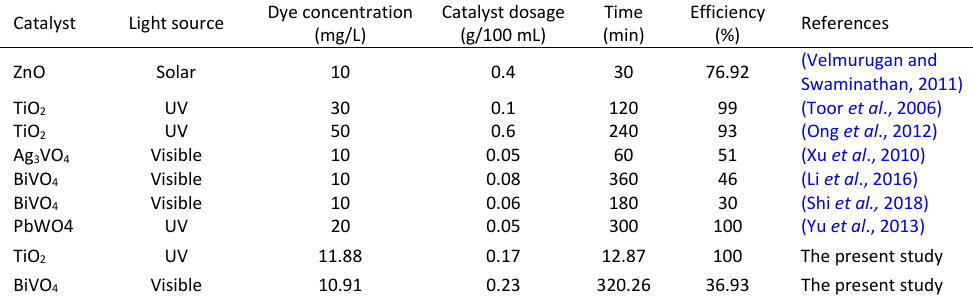
Fig. 9: Effect of initial concentration of AO10 on photo-oxidative removal of dye; [TiO 2 ] = 0.25 g/100 mL, pH=3. Table 6: Comparison of the two systems studied in this work with other processes Catalyst